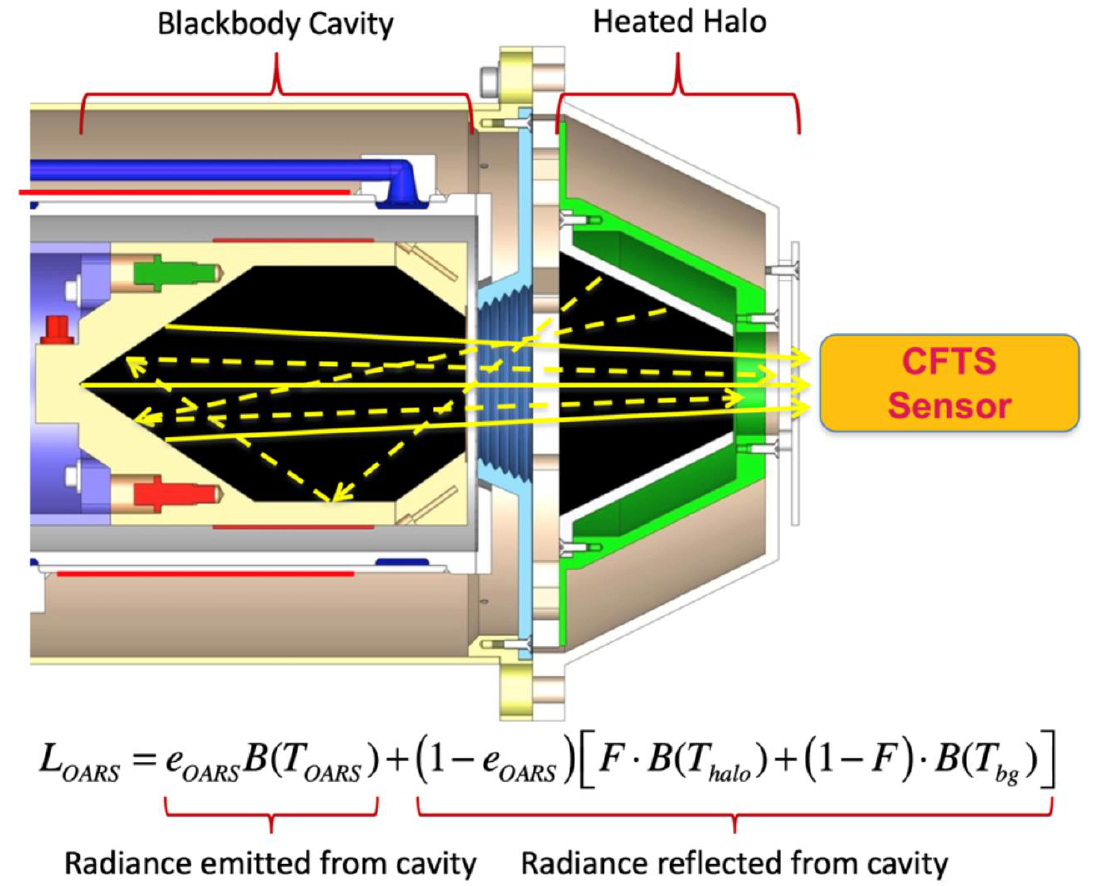
Figure 22. Illustration of the Heated Halo approach for measuring blackbody hemispheric-to-normal spectral emissivity on orbit.